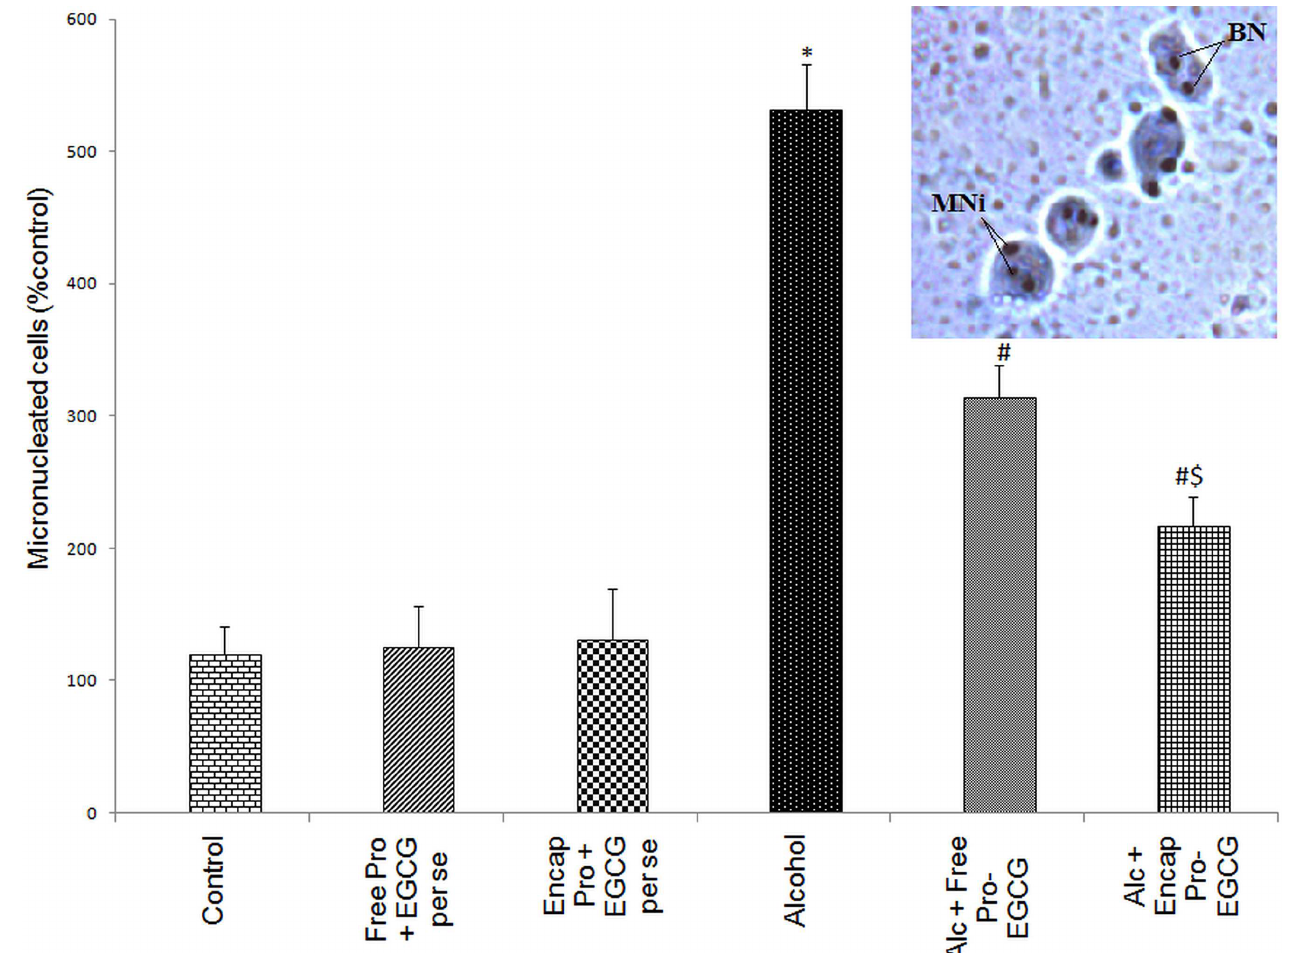
Fig 9. Micronuclei analysis in the hepatocytes of alcohol-fed rats. Effect of co-enapsulated Probiotic-EGCG on the extent of micronuclei formation in hepatocytesof alcoholadministered rats. Values are expressedas percentageof micronucleated cells. * p < 0.001vs. control, # p < 0.01 vs. control, #$ p < 0.05vs. control; Inset - Dividingcells showingbinuclei(BN) and micronuclei (MN) in hepatocytesof